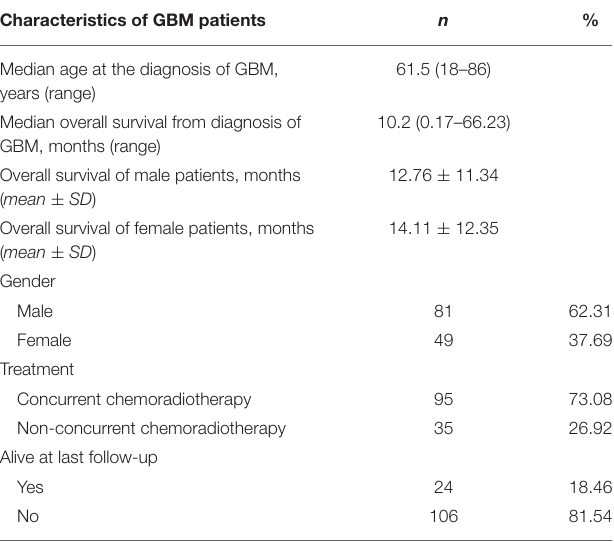
TABLE 1 | Demographic characteristics and clinical data of 130 primary glioblastoma (GBM) patients. Characteristics of GBM